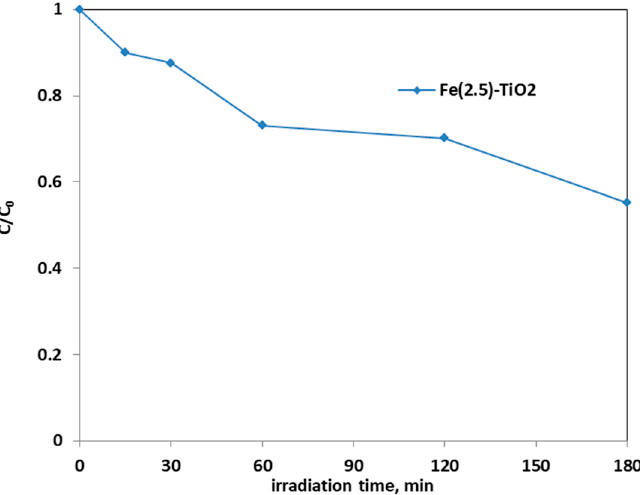
Figure 17. Photocatalytic discoloration of aqueous solution containing phenol (10 mg L − 1 ) using 0.3 g of optimized Fe(2.5)-TiO 2 photocatalyst under visible light irradiation.